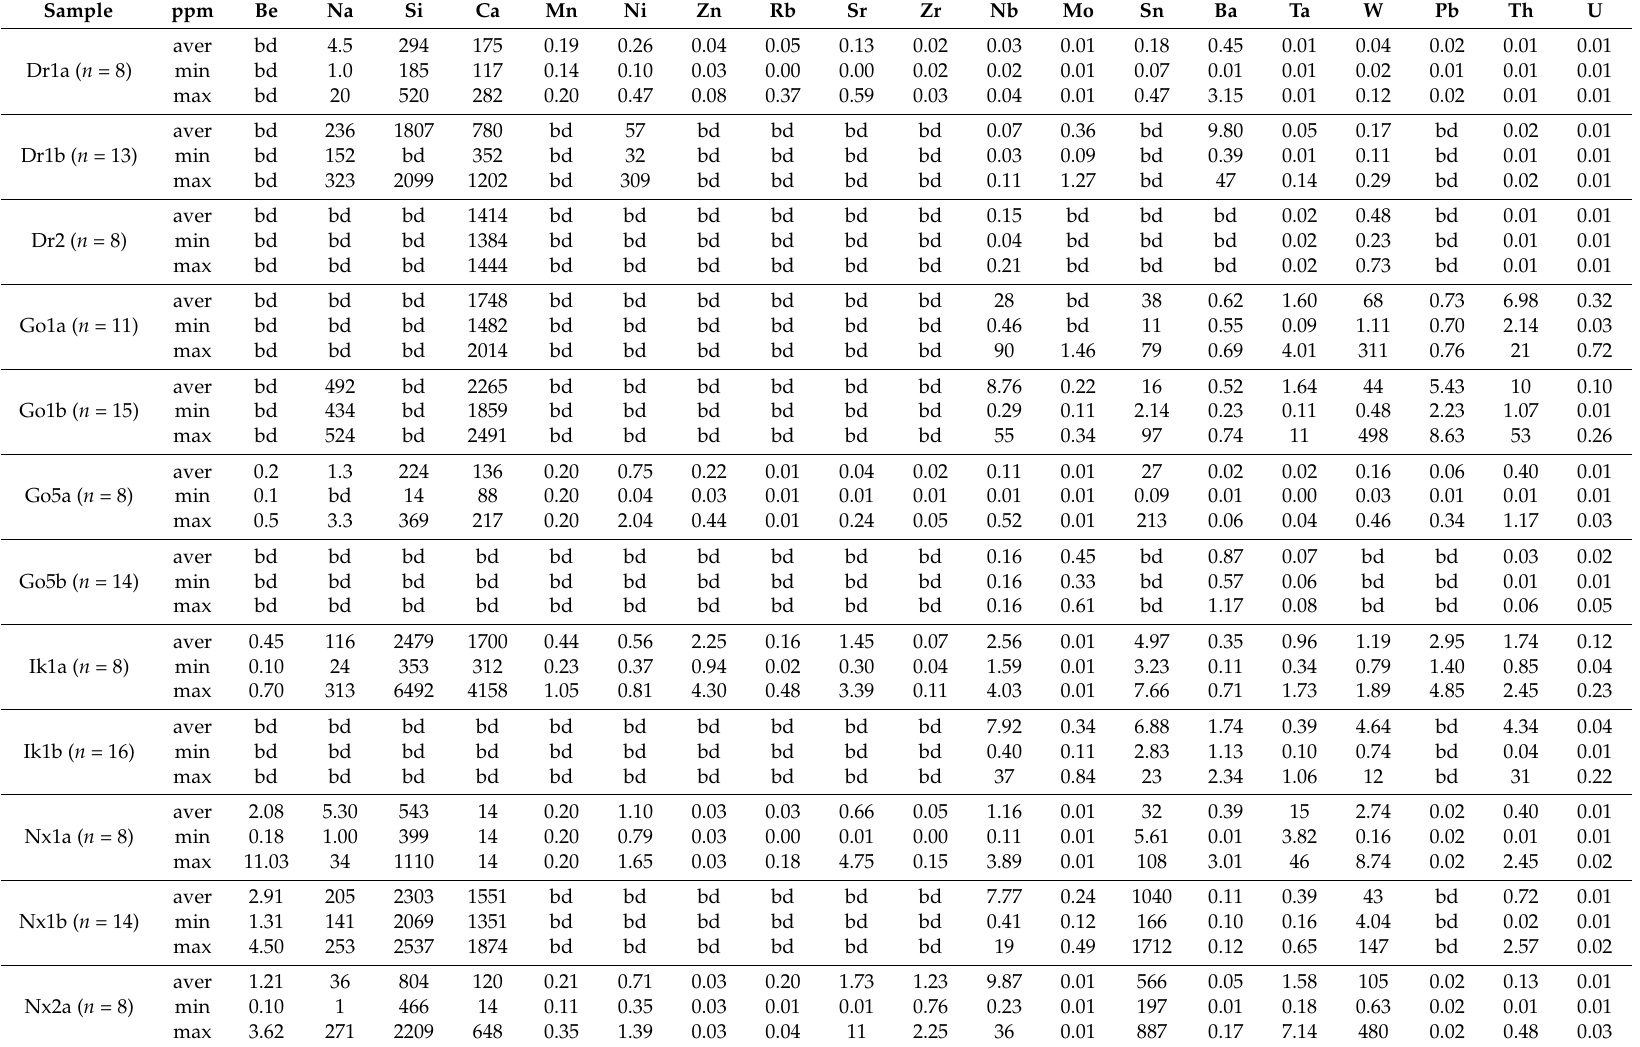
Table 4. Other trace elements LA-ICP-MS analyses (ppm) of the Greek corundum